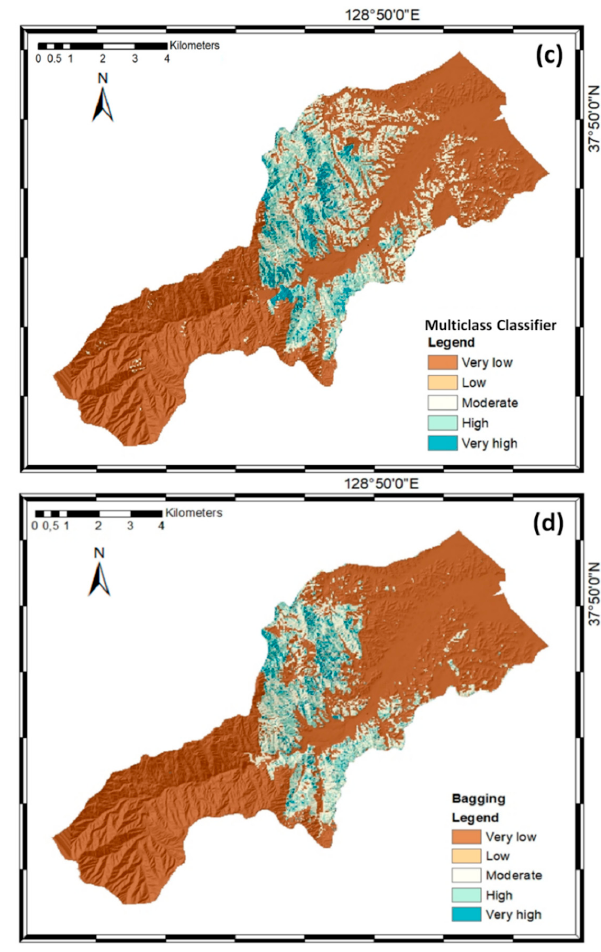
Figure 5. Landslide susceptibility maps of the Sacheon-myeon area based on the ( a ) AdaBoost, ( b ) LogitBoost, ( c ) Multiclass Classifier, and ( d ) Bagging models.